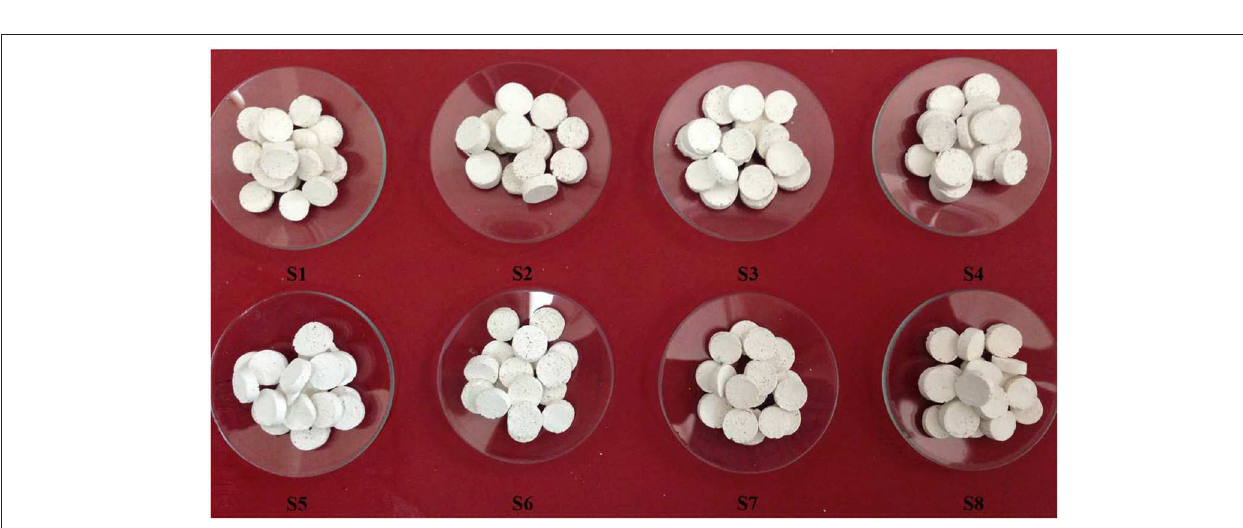
FIGURE 4 | Digital photographs of the porous CMC- g -PAM/ATP hydrogels prepared through the use of Pickering-MIPEs with various vegetable oils.